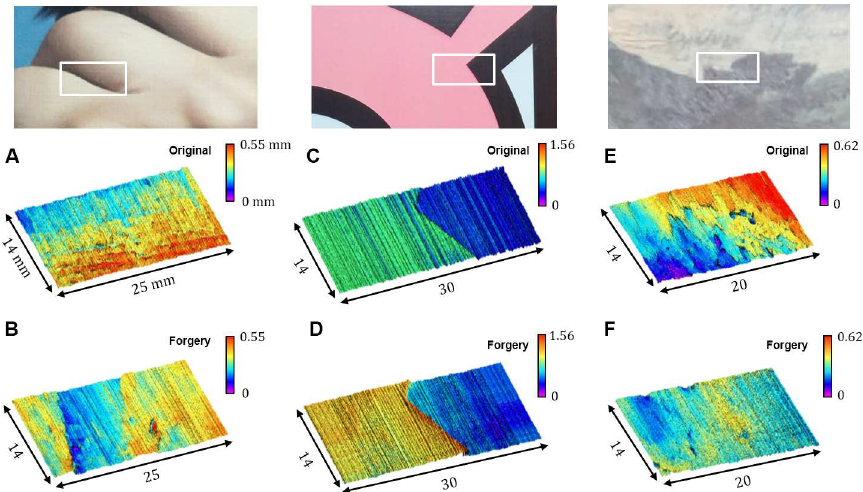
and (B), (D), (F) are the forgeries data.